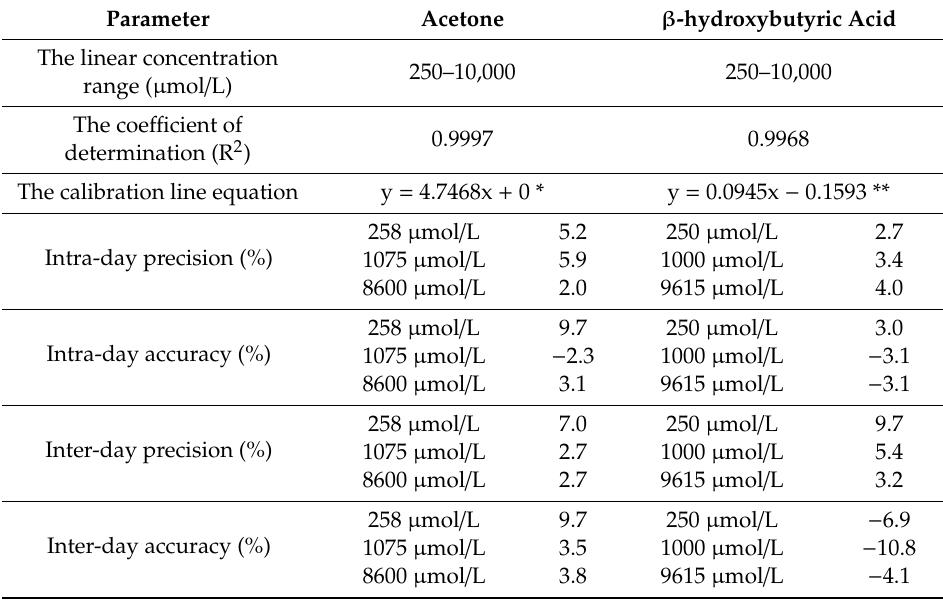
Table 4. Validation parameters of the methods for determining acetone and β -hydroxybutyric acid; * the calibration line equation concerns mg / mL, ** the calibration line equation concerns µ g /